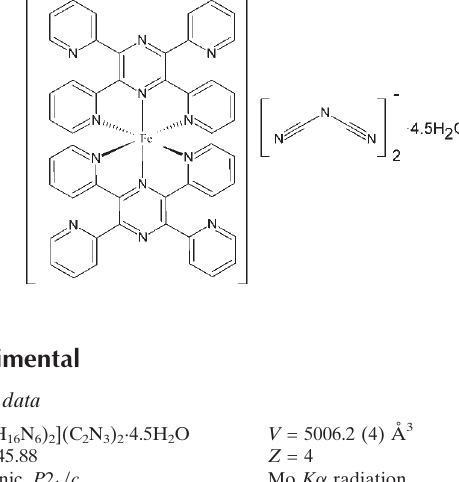
Key indicators: single-crystal X-ray study; T = 293 K; mean (cid:2) (C–C) = 0.004 A˚; disorder in solvent or counterion; R factor = 0.063; wR factor = 0.168; data-to- parameter ratio = 20.4.